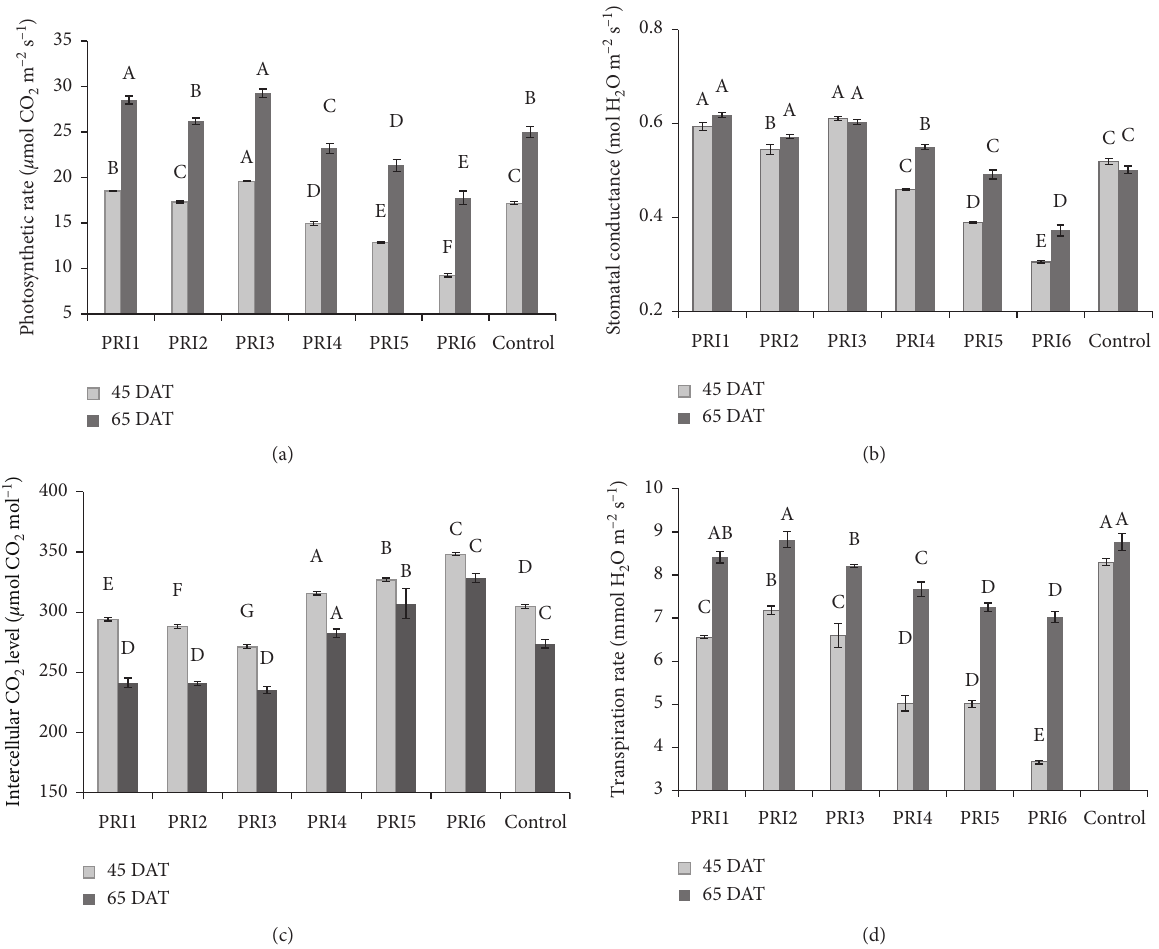
Figure 3: Leaf gas exchange measurements of rice crop under the split root experiment. Changes in leaf photosynthetic rate ( P stomatal conductance ( g s ) (b), intercellular CO 2 concentration ( C i ) (c), and transpiration rate ( T r ) (d) at different partial root-zone irrigation treatments. Error bars indicate one standard error of the mean. Different letters denote significant differences among means derived using an ANOVA and Student’s t